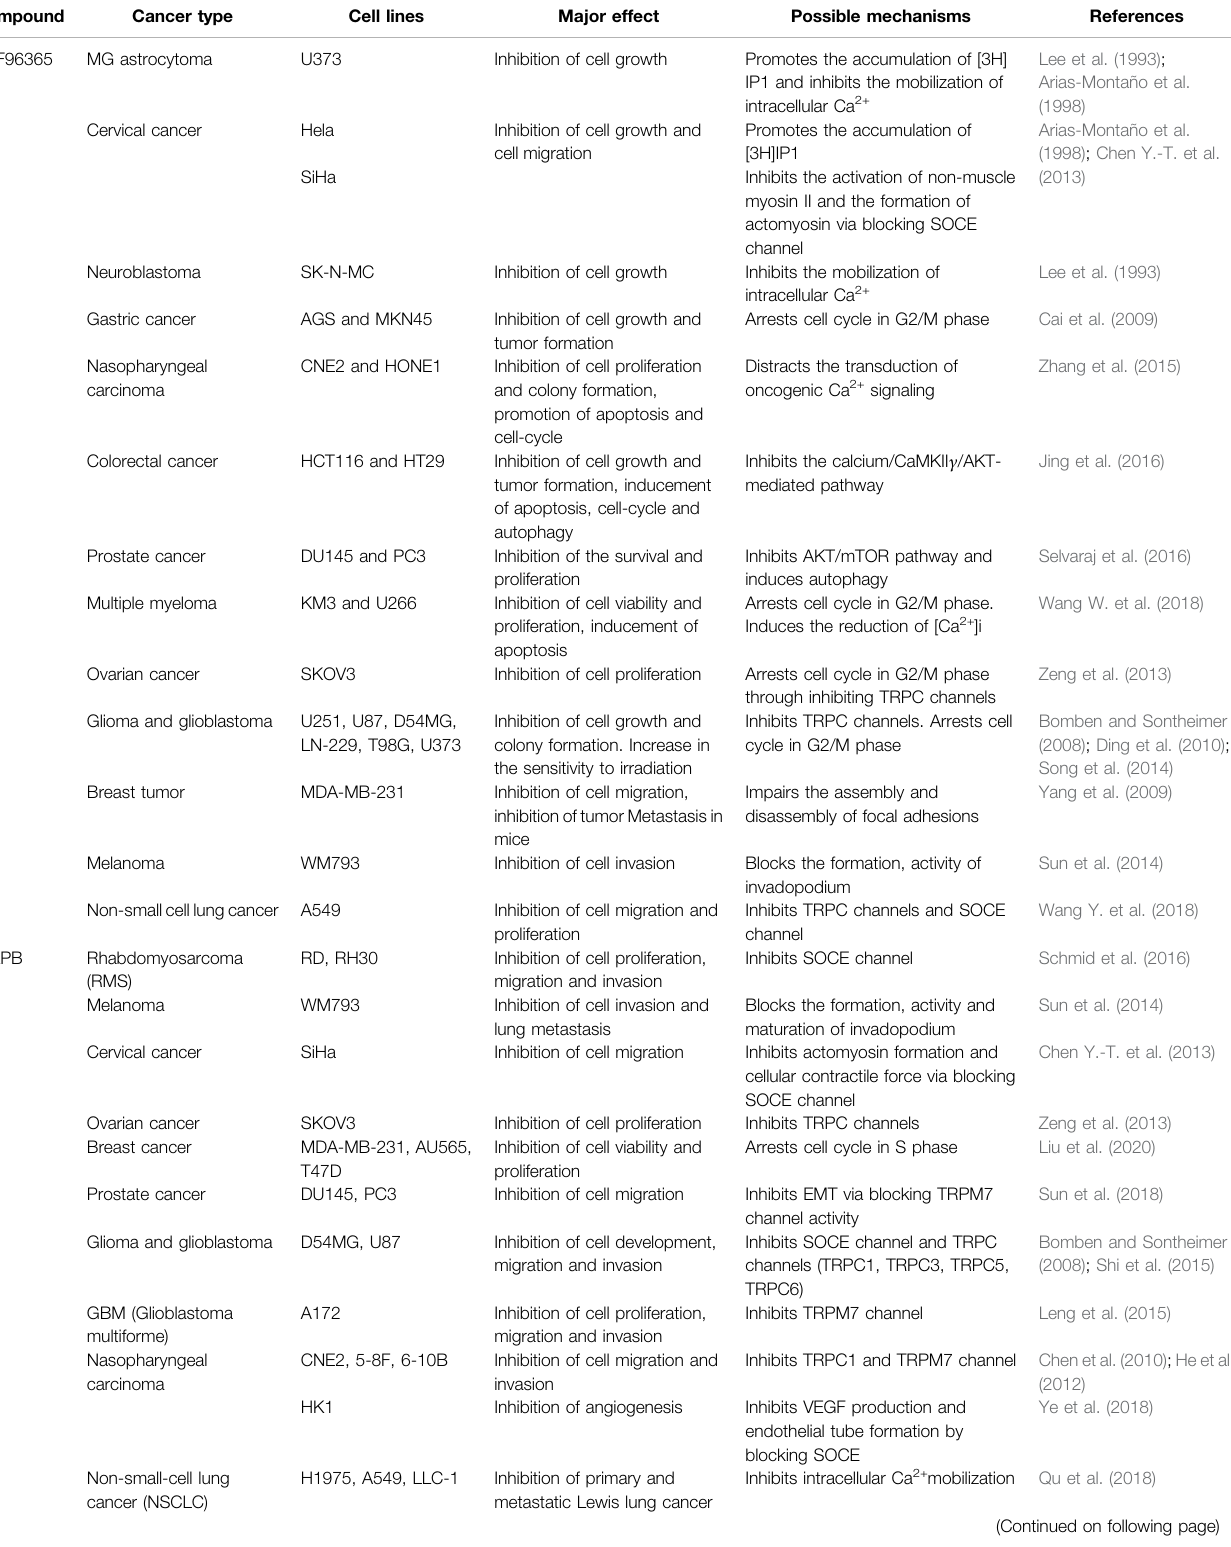
TABLE 3 | SOCE inhibitors in cancer